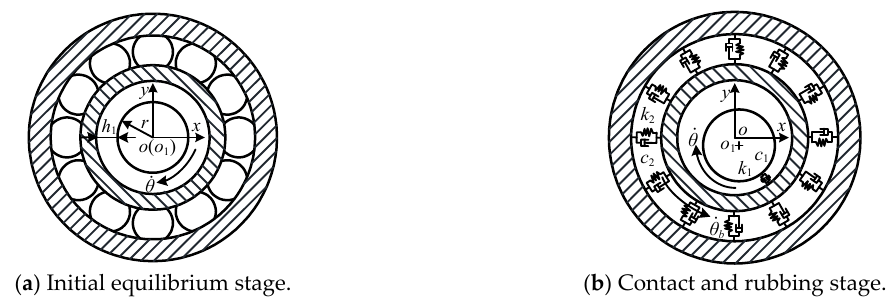
Figure 6. Mechanical model of the protection device for the “rotor-deep groove ball bearing”.